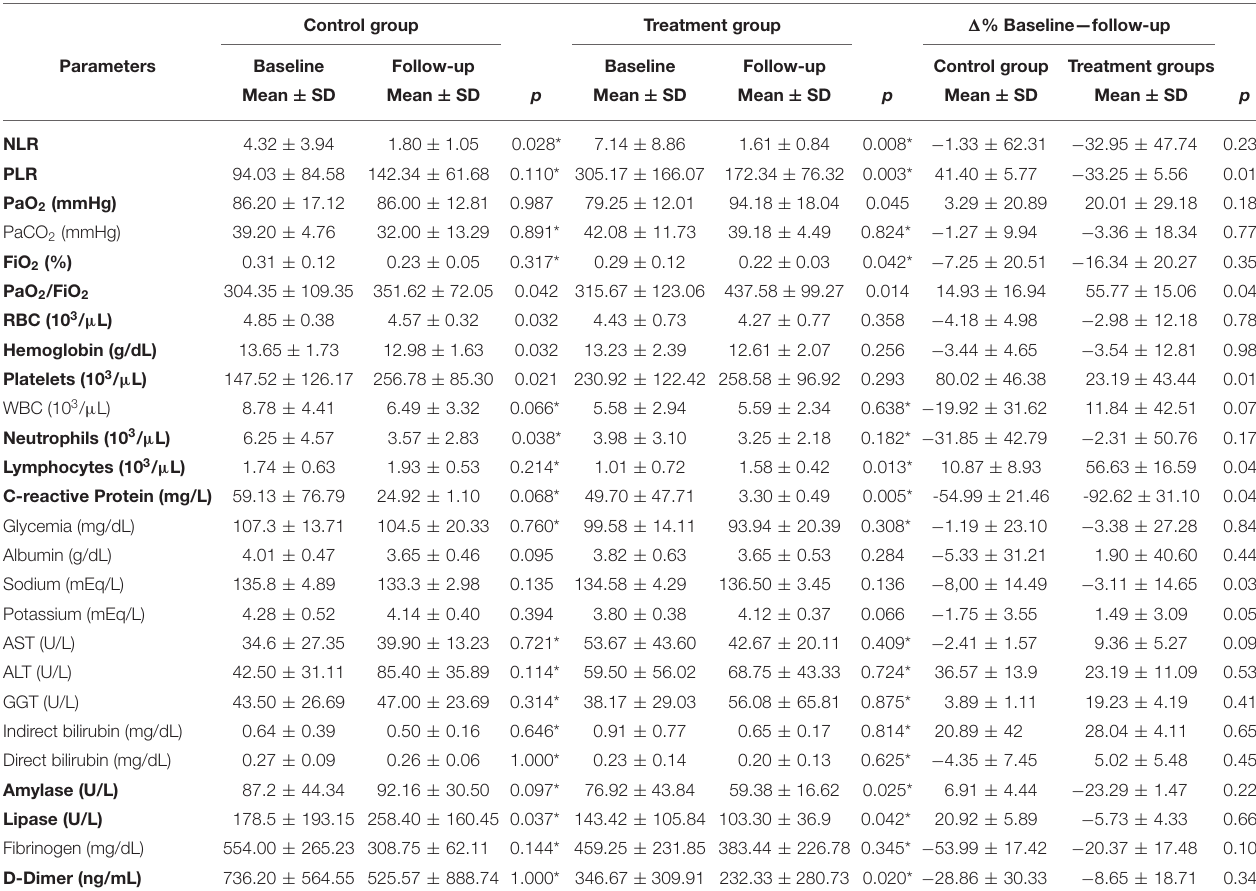
TABLE 3 | Differences between baseline and follow-up in each